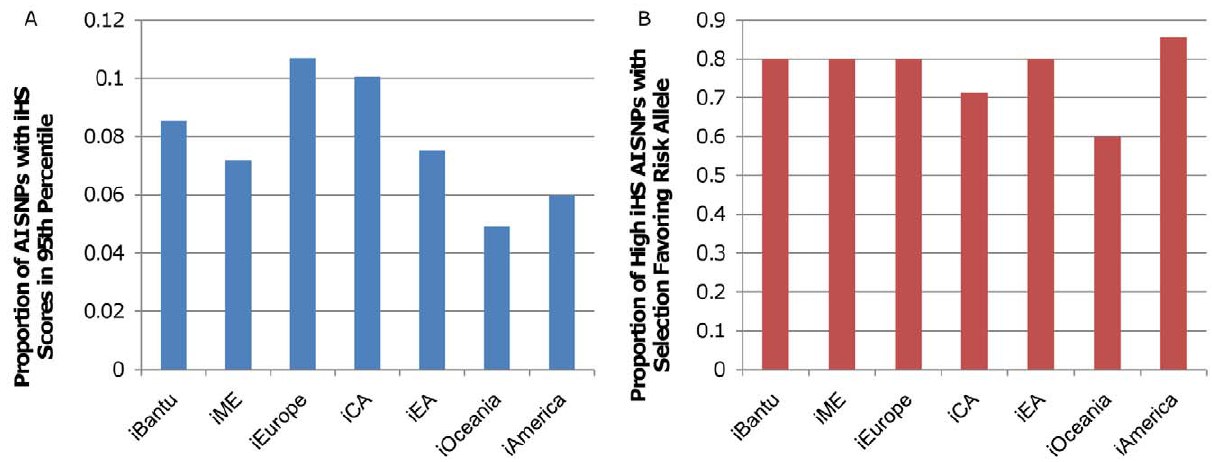
Figure 5. iHS scores for autoimmune disease–associated SNPs. A) The proportion of autoimmune disease (AI) GWAS SNPs with iHS scores in the 95 th percentile or above for each continent. The cutoff value for the 95 th percentile was determined separately for each continental iHS measure. This cutoff was 2.04 for iBantu, 1.97 for iME, 2.09 for iEurope, 1.98 for iCA, 2.05 for iEA, 1.99 for iOceania, and 1.98 for iAmerica. B) The proportion of AI GWAS SNPs with iHS scores in the 95 th percentile or above for each continent where the risk allele is associated with a longer haplotype than the protective allele.